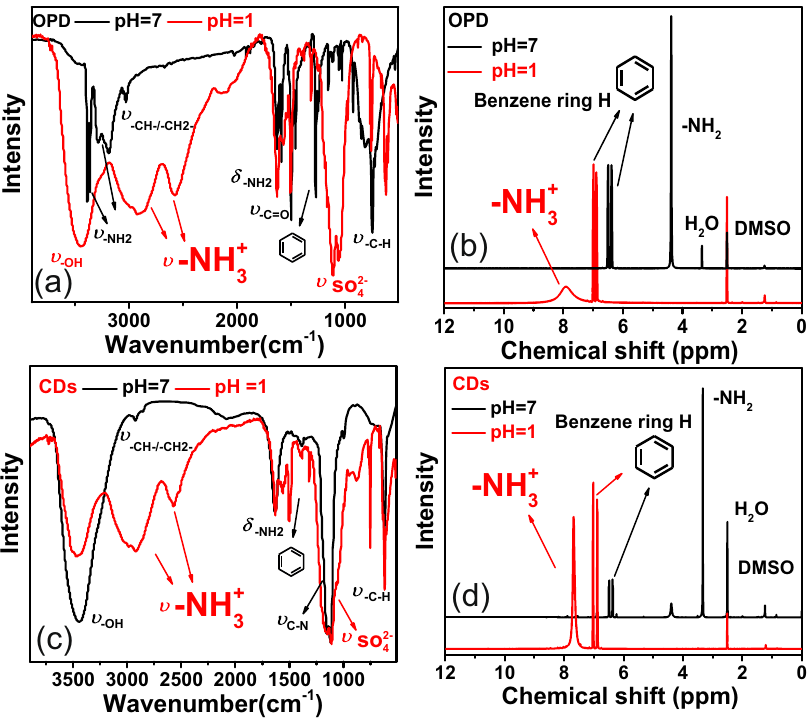
Fig. 4 Structural evolution of functional groups during protonation treatment. a , b FTIR and 1 H-NMR spectra of OPD with or without protonation treatment. c , d FTIR and 1 H-NMR spectra of CDs with or without protonation treatment (black line: spectra of samples without protonation treatment; red line: spectra of samples with protonation